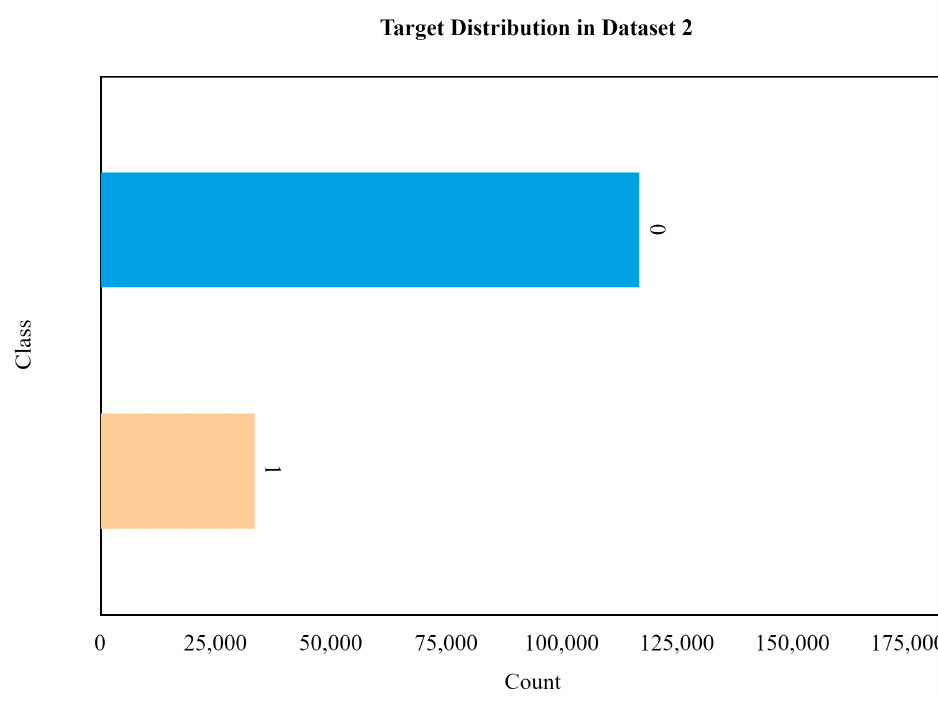
Figure 5. Target Variable Distribution in IoR Dataset.